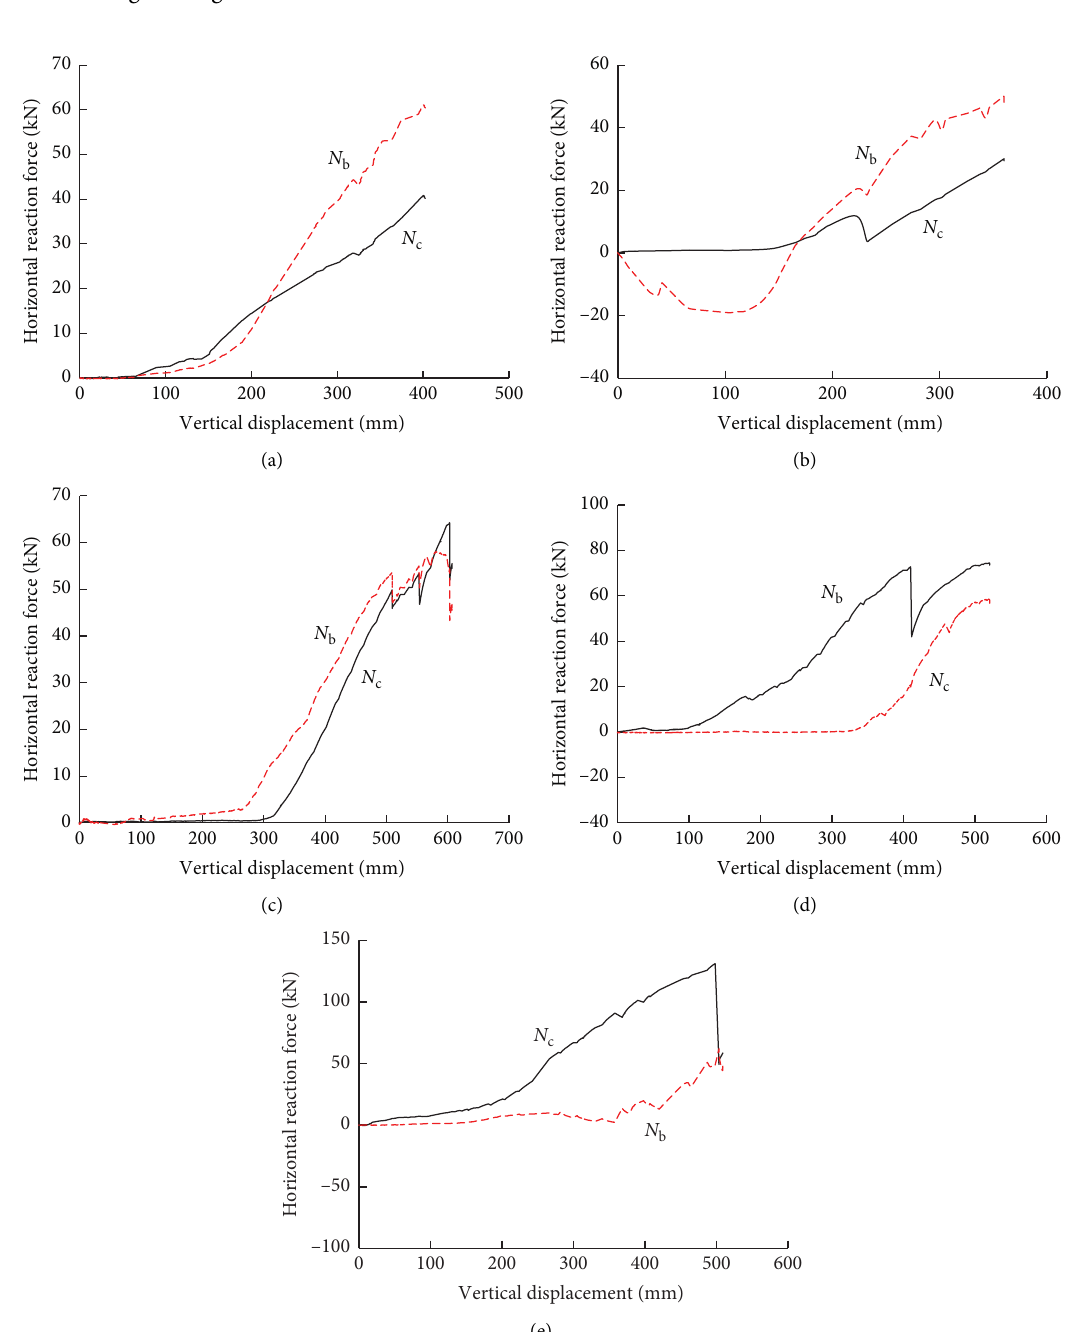
Figure 7: Horizontal reaction forces versus vertical displacement curves (a) S1. (b) S2. (c) S3. (d) S4. (e)